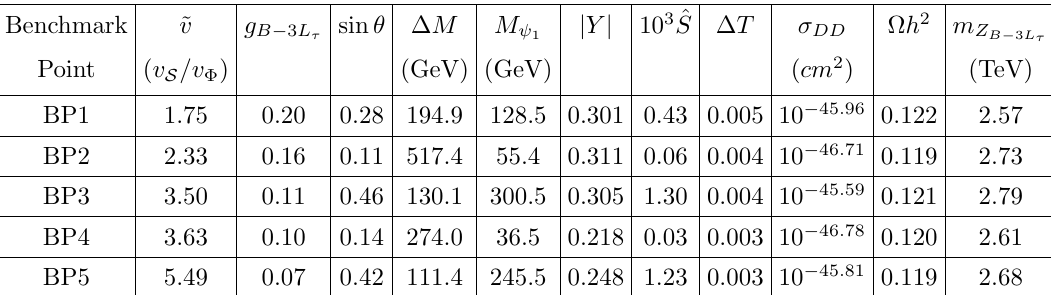
Table 2 . Choices of the benchmark points used for collider analysis. Masses, mixings, relic density and direct search cross-sections for the DM candidate are tabulated. In each case corresponding mass of Z B (cid:0) 3 L is also quoted. (cid:28)